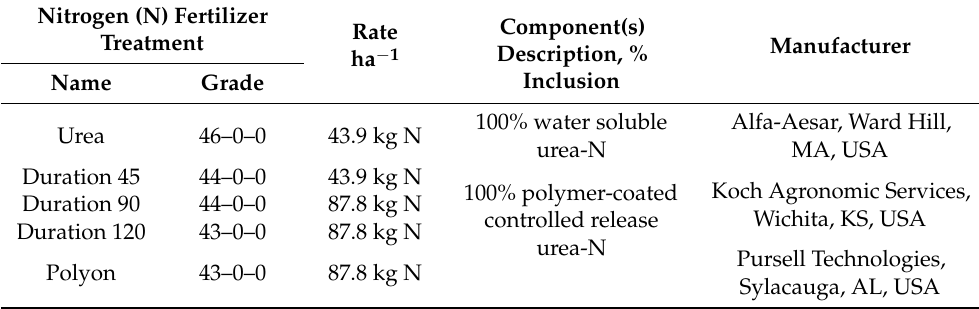
Table 1. Descriptions of urea-based nitrogen fertilizer products evaluated in the field study. Nitrogen (N)